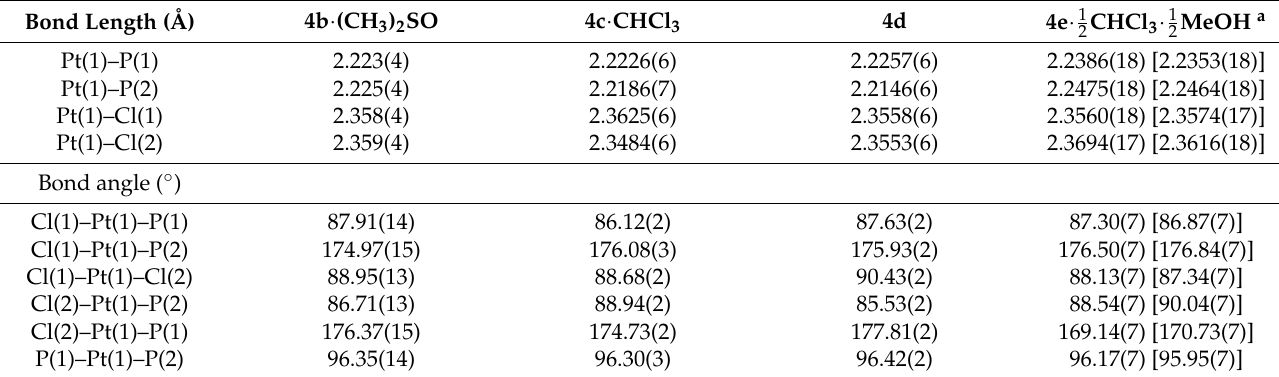
a Values in parentheses are for the second independent molecule.